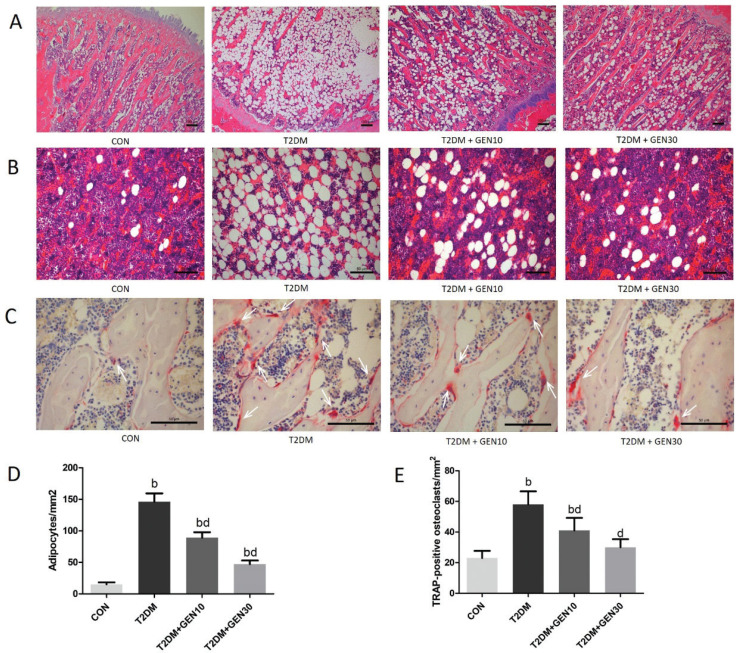
The left femurs were removed after 8 weeks of genistein or vehicle treatment. The histomorphology of bone tissues with H&E and TRAP staining was observed under a microscope. (A) Representative H&E staining of femur sections from each group. (B) Bone marrow adipocytes of rats with H&E staining in each group. (C) Representative TRAP staining of femur sections from each group. TRAP-positive osteoclasts with red cytoplasm and blue nucleus are indicated with white arrows. (D) Quantification of the number of adipocytes per square millimeter in left femurs. (E) Quantification of the number of TRAP-positive osteoclasts per square millimeter in left femurs. Values are expressed as mean ± SD, n = 10 or 11. aP < 0.05, bP < 0.01 compared with CON; cP < 0.05, dP < 0.01 compared with T2DM.